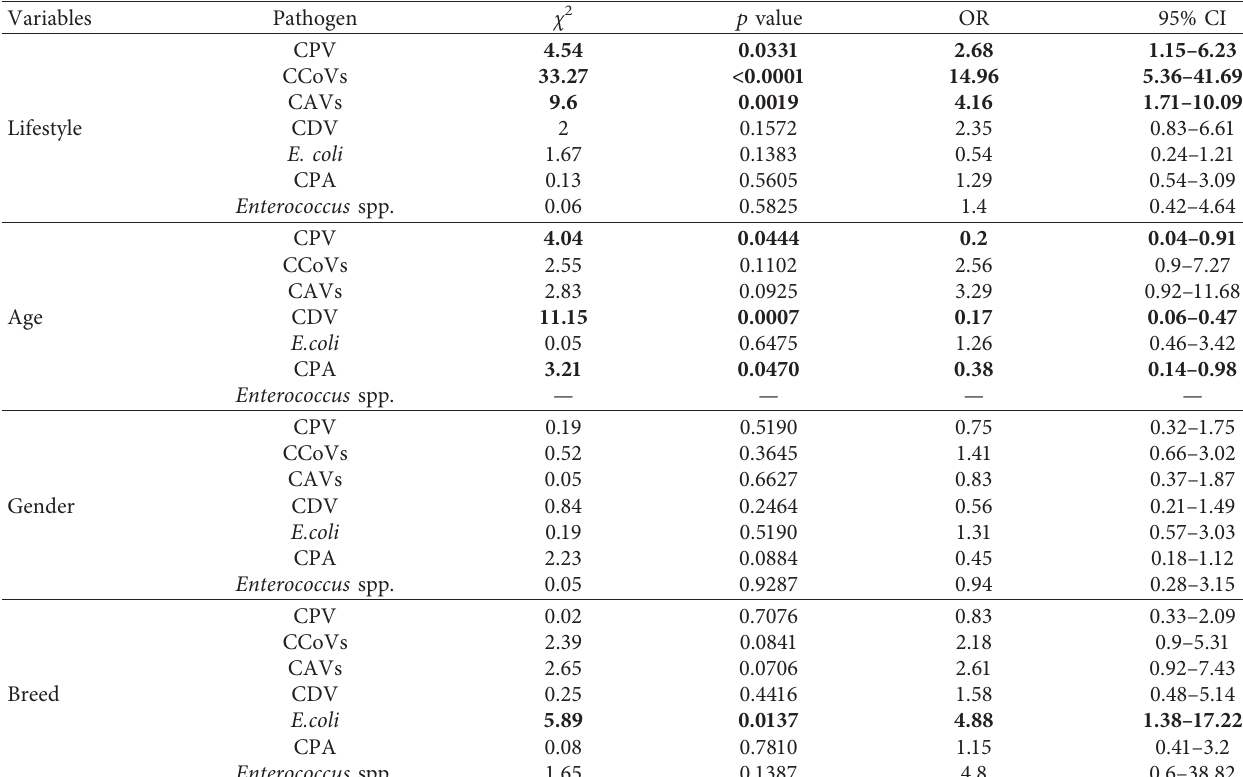
Table 4: Results of the univariate analyses showing the association of the variables to the risk of infection for the most frequently detected